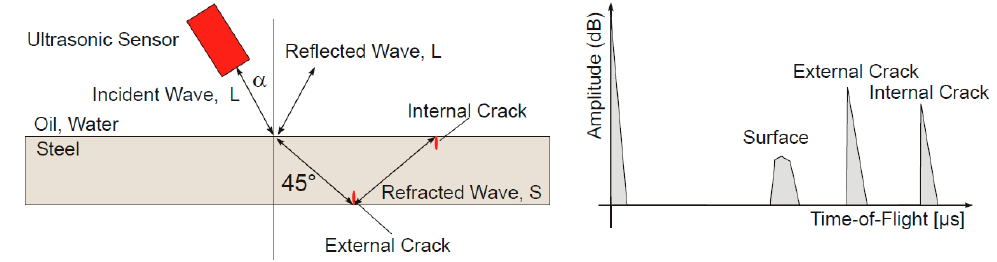
Figure 11. Principle of ultrasonic measurement.